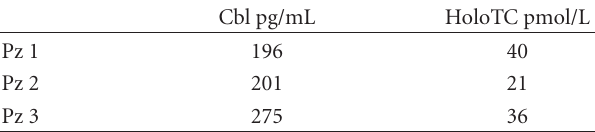
Table 2: HoloTC in alcoholics with low-borderline Cbl